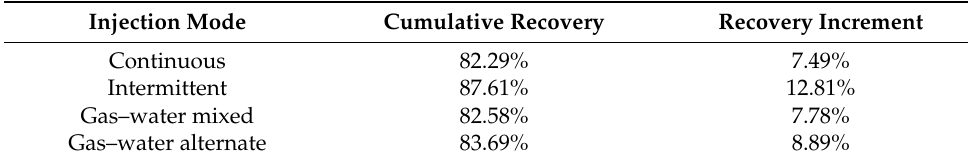
Figure 12. Production curves under different injection modes: ( a ) water cut; ( b ) gas production rate; ( c ) cumulative recovery. Table 3. Recovery increments of different injection modes.